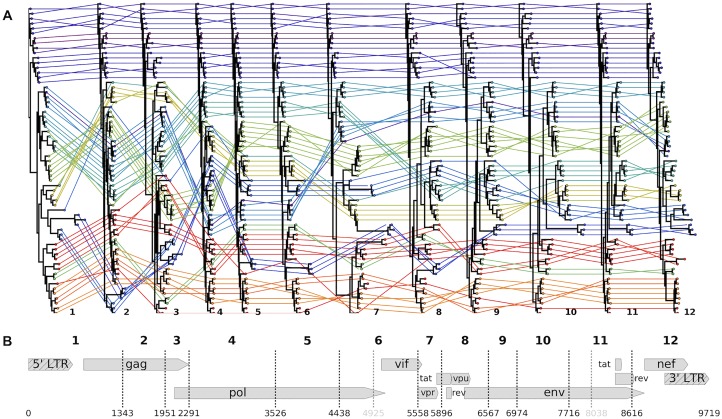
Inferred interlineage recombination breakpoints and supporting tree topologies.The SIV LANL compendium, slightly modified to reduce overrepresentation of HIV, was analyzed with GARD to identify 13 recombination breakpoints across the genome (dashed lines in B; numbering according to the accepted HXB2 reference genome—accession K03455, illustrated). Two of these breakpoints were omitted from further analyses because they created extremely short fragments (< 500 bases; gray dashes in B). For each of the 11 remaining breakpoints used in further analyses, we split the compendium alignment along these breakpoints and built a maximum likelihood tree, displayed in A. Each viral sequence is color-coded by host species, and its phylogenetic position is traced between trees. Heuristically, straight, horizontal colored lines indicate congruent topological positions between trees (likely not a recombinant sequence); criss-crossing colored lines indicate incongruent topological positions between trees (likely a recombinant sequence).